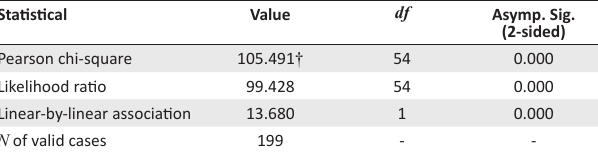
TABLE 4b: Correlation between type of injuries and their influence on careers and performance as in Table 4a. Statistical Value df Asymp. Sig.